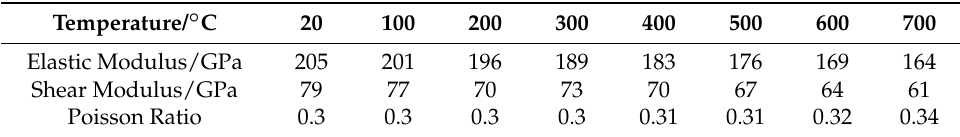
Table 1. Mechanical properties of GH4169 alloy.